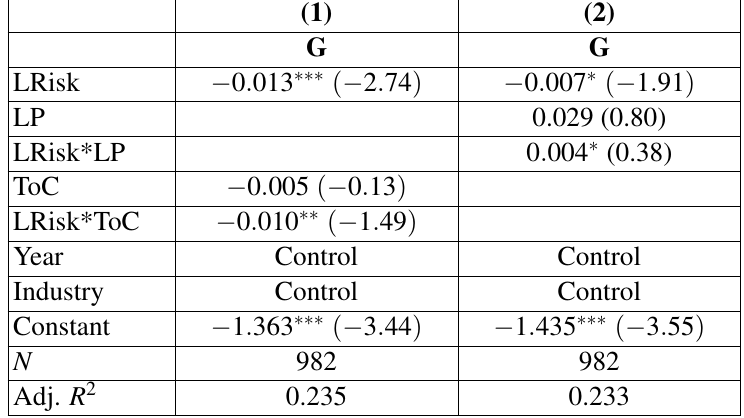
Table 5 The moderating role of civil litigation types and judicial local